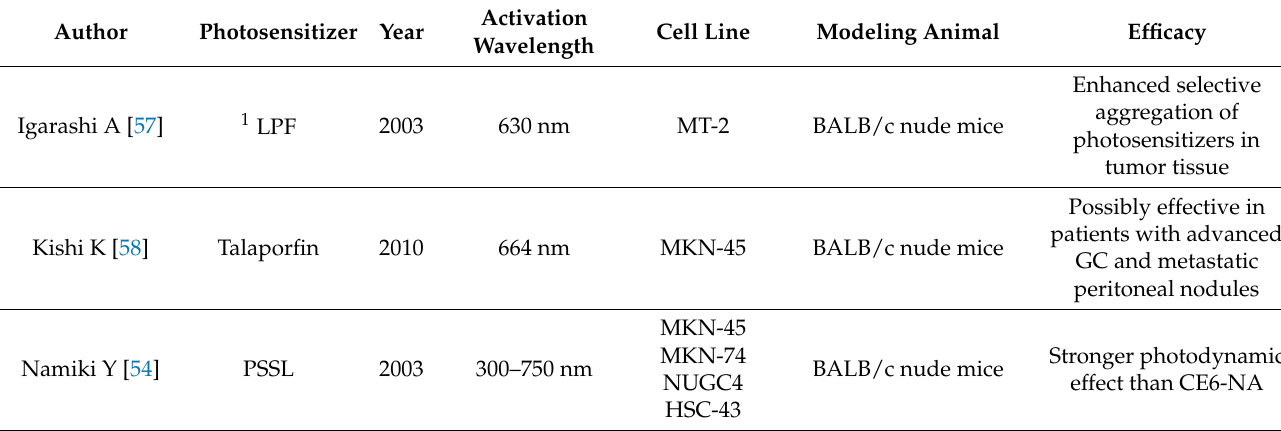
Table 3. In vivo study of PDT for GC.